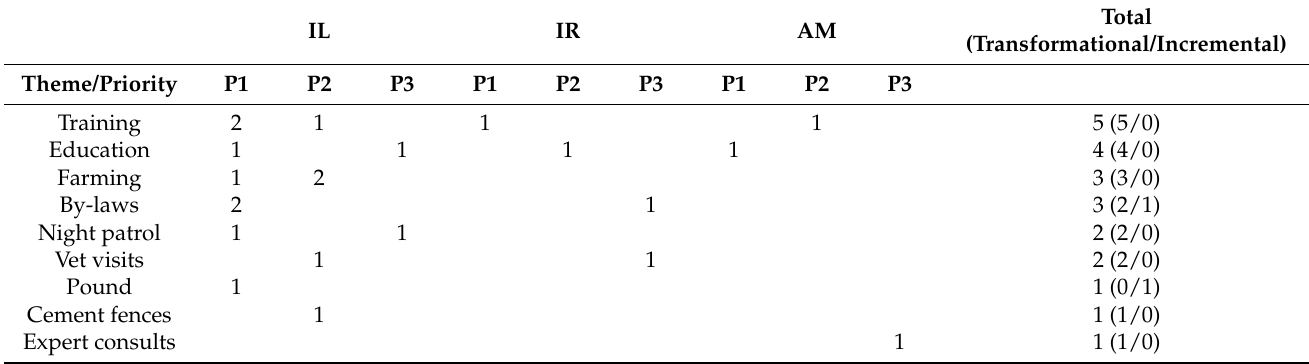
Table 3. A summary of the proposed solutions showing the frequency and priority (priority 1 = P1; priority 2 = P2; priority 3 or 4 = P3) for each stakeholder group. The totals for each theme across groups and their split between transformative and incremental solutions are also